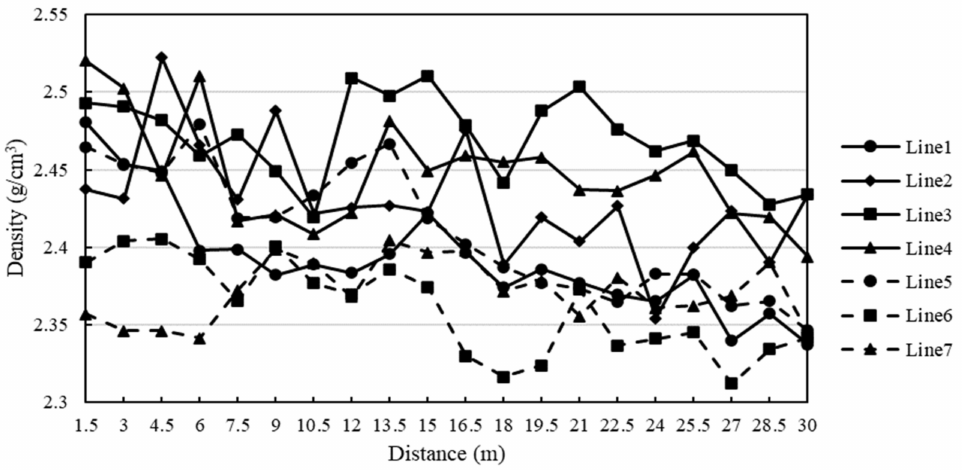
Figure 10. Density distribution of the tested